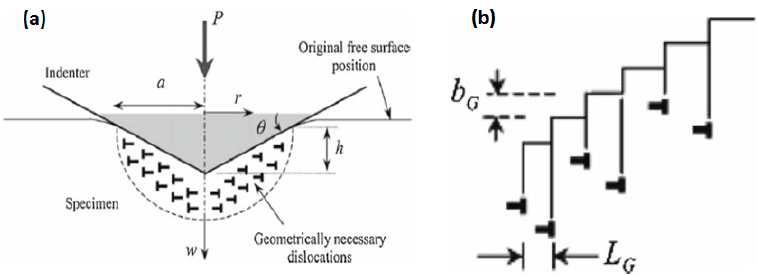
Figure 24. Model of geometrically necessary dislocation for a conical indent: ( a ) Sample being indented by a rigid conical indenter; ( b ) Deformation loops created during indentation process [62].